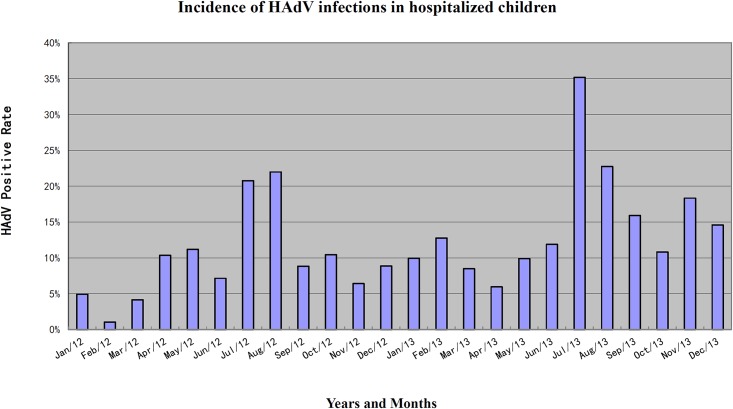
Monthly distribution of HAdV-positive hospitalized children.